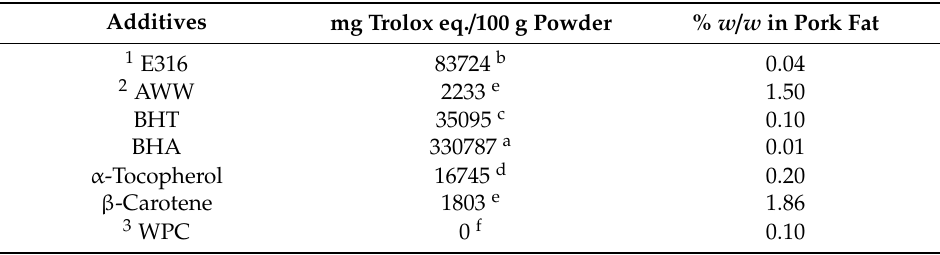
Table 4. Trolox equivalence of additives added to pork fat determined by cupric ion reducing antioxidant capacity (CUPRAC) assay.